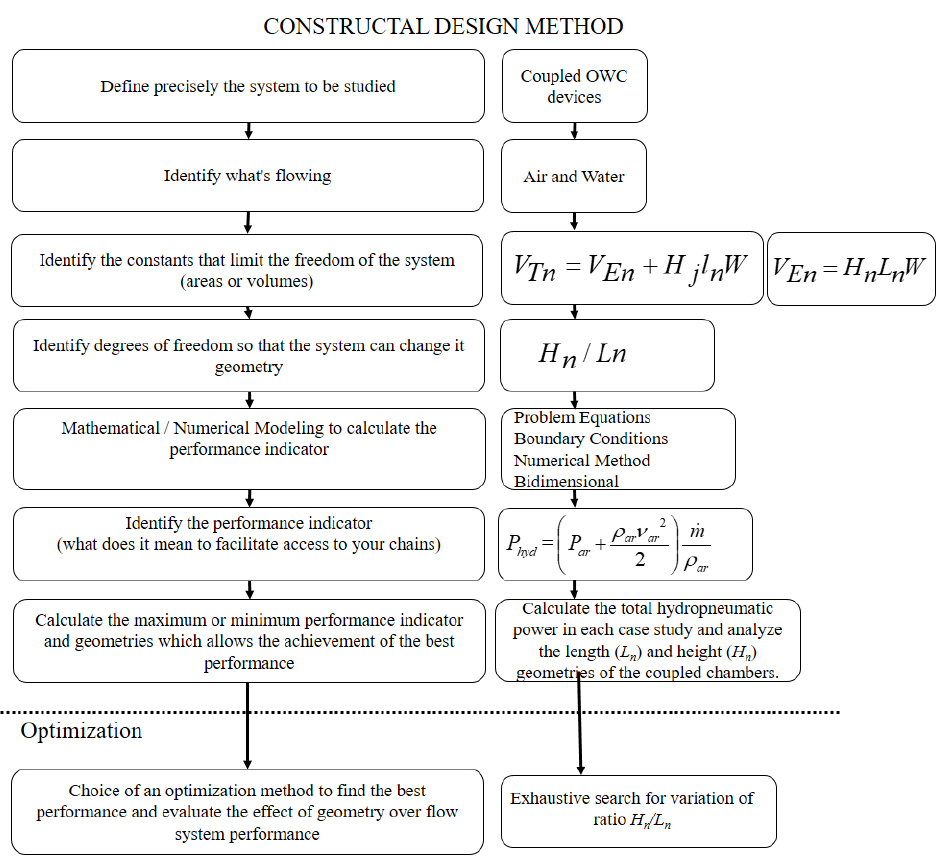
Figure 6. Scheme of execution of the Constructal Design method.